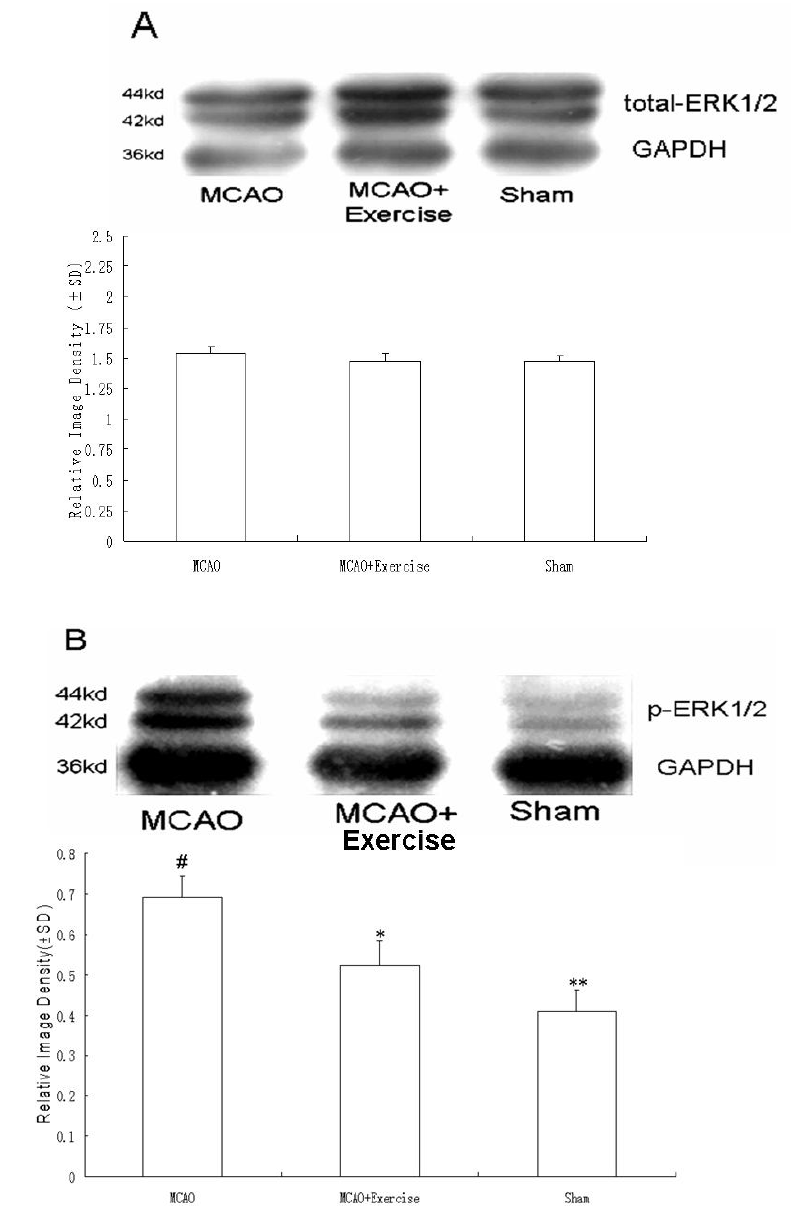
Figure 4. Protein levels of total ERK1/2 and phospho-ERK1/2. A) No significant differences were observed for total-ERK1/2. B) Phospho-ERK1/2 was higher in MCAO than sham surgery and was partially reduced with exercise. Data represent mean ± SD. # P < 0.05 relative to sham surgery. **P < 0.05 relative to MCAO+Exercise.* P < 0.05 relative to